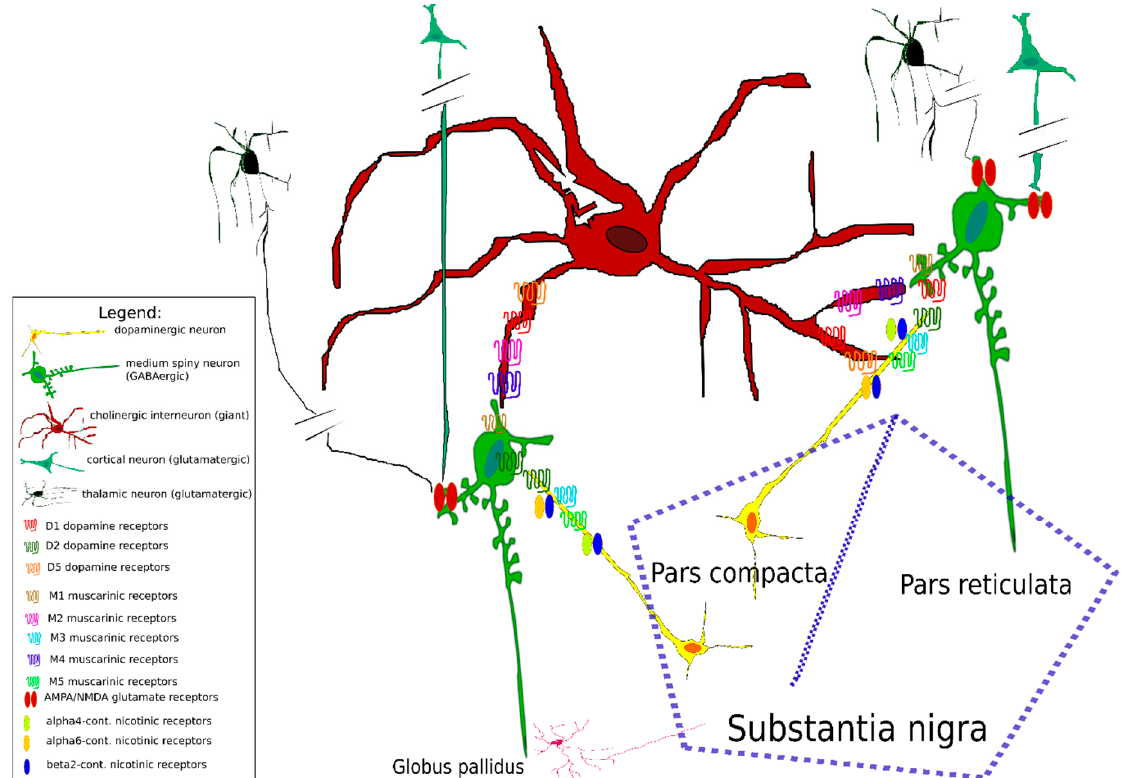
Figure 1. Schematic representation of interconnections between neurons in the striatum. The direct pathway projects preferentially to the globus pallidus internal segment (not shown)/substantia nigra pars reticulata, while the indirect pathway projects to the globus pallidus external segment. Efferentation to the entopeduncular nucleus is not shown. The substantia nigra (dotted blue line) is divided into the pars compacta and pars reticulata. The connections are simplified. Specific receptors are shown by symbols. Alpha4, alpha6, beta2-cont. nicotinic receptors: nicotinic receptors containing the α 4 , α 6 , β 2 subunits, respectively. The neurons are schematized (see legend for explanation), and receptor localization is not specified (i.e., receptors are not shown to be expressed in nerve terminals or bodies). Please note that cholinergic neurons are also able to release glutamate. Both cholinergic and dopaminergic neurons can transmit the signal using volume transmission (see text); thus, the neurotransmitter can affect relatively remote receptors. Based on the data from [3,20,28,33,34,36–39].